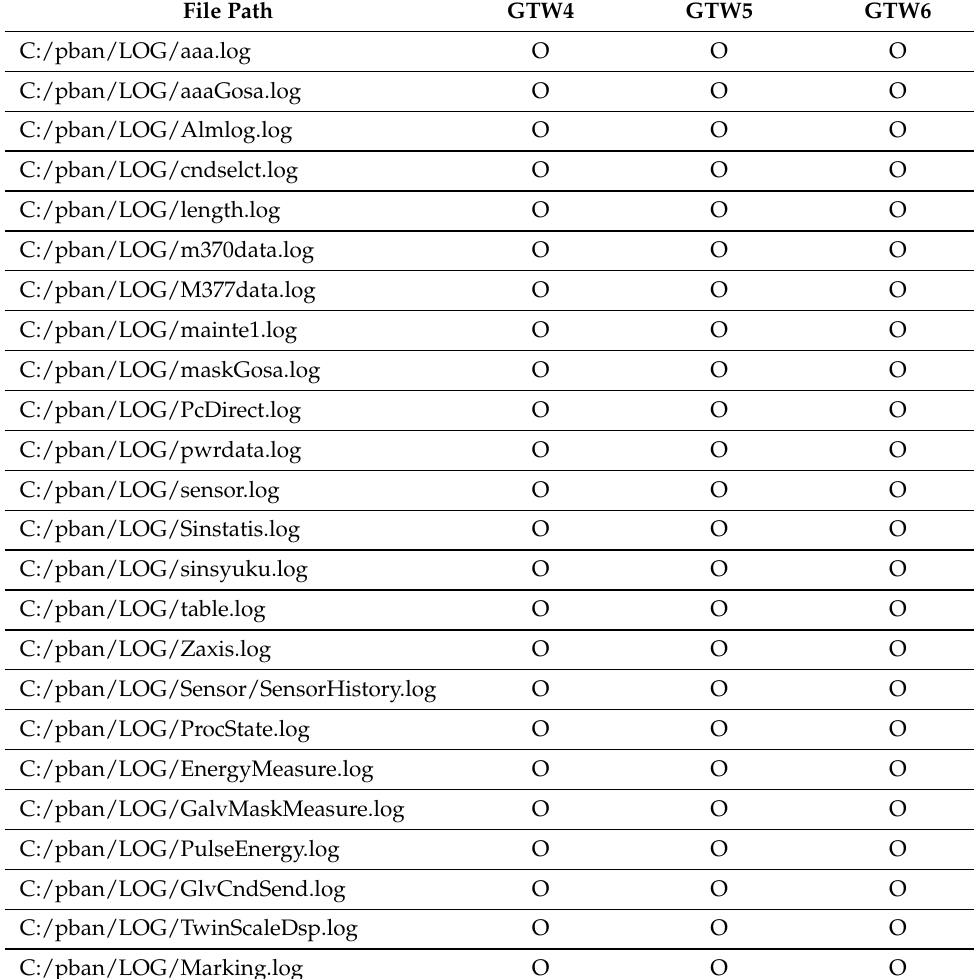
Table 3. The data from the log files of 24 laser processing machines. File